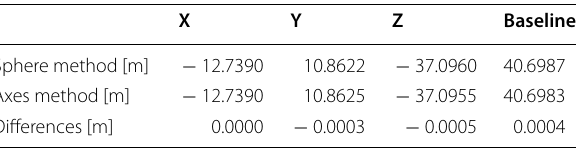
Table 4 VLBI–GNSS local-tie vectors estimated by axes method and sphere method